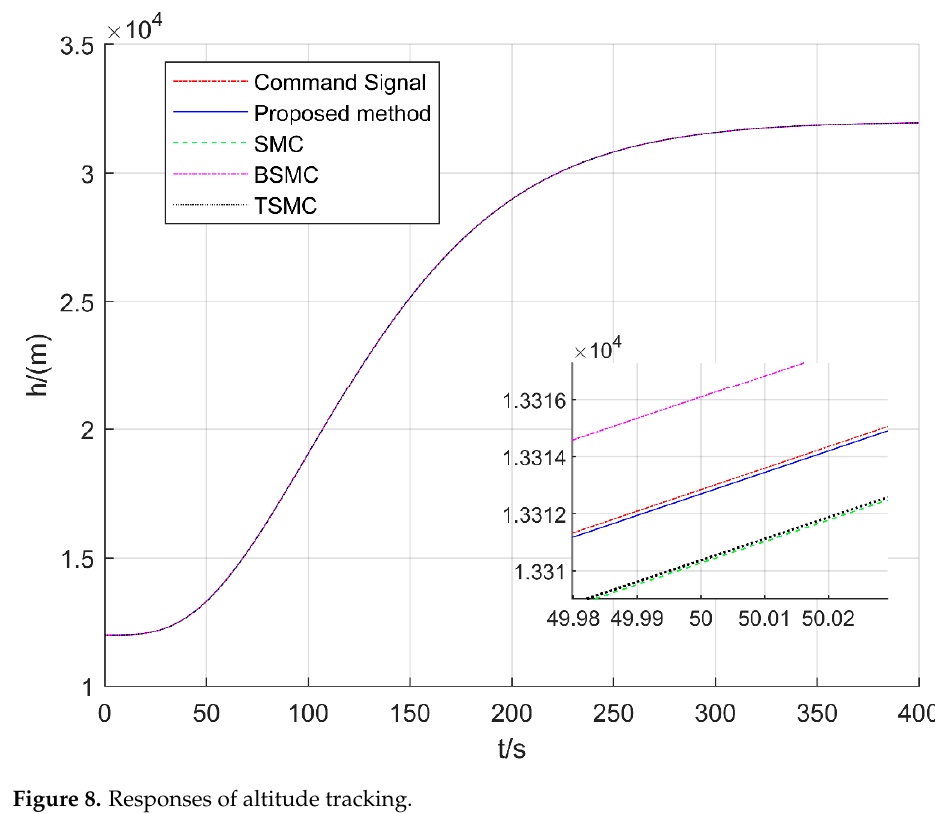
Figure 7. Tracking errors of velocity.